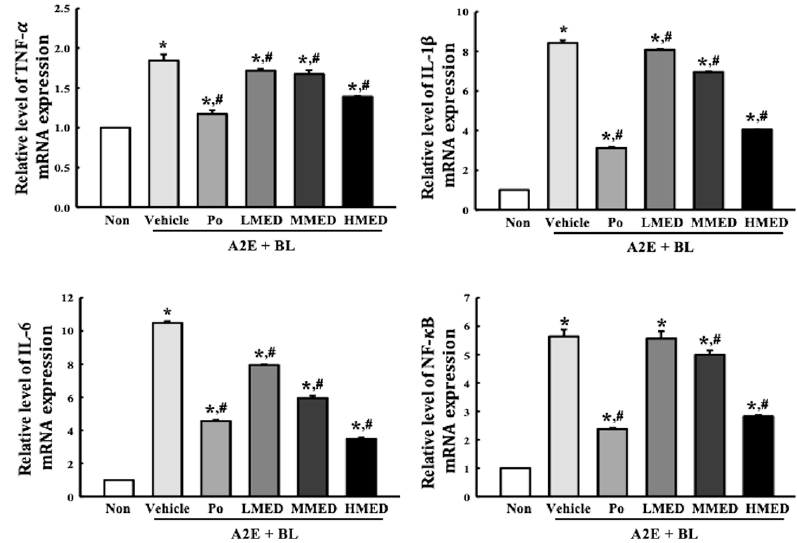
Figure 10. mRNA expression of inflammatory cytokines in MED + A2E + BL treated ARPE19 cells. The levels of TNF- α , IL-1 β , IL-6, and NF- κ B transcripts were measured in the total mRNA of ARPE19 cells by RT-qPCR using specific primers. The relative level of each transcript was determined based on the level of β -actin. The total RNAs were prepared from two to three samples per group, and RT-qPCR analyses for each sample were analyzed in duplicate. All values in results are represented as the means ± standard deviation (SD). * indicated statically significance compared to the Non treated group, while # indicated statically significance compared to the Vehicle + A2E + BL treated group. Abbreviations: TNF- α , tumor necrosis factor α ; IL, Interleukin; NF- κ B, Nuclear factor kappa light chain enhancer of activated B; MED, methanol extracts of Dipterocarpus tuberculatus Roxb.; A2E: N-retinylidene-N-retinylethanolamine; BL, Blue light.